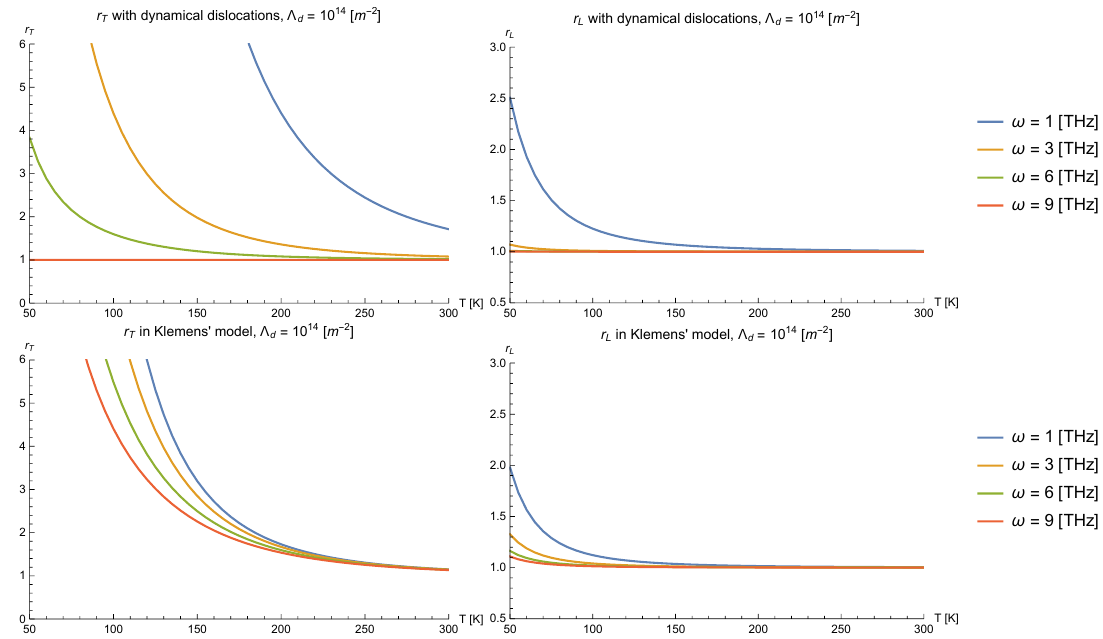
Figure 8. Differential anisotropy ratio r ι as a function of temperature T for different frequencies ω . Upper panels: Present work, based on a dynamical response of dislocations to phonons. Lower panels: Klemens model, based on a static response of dislocations to phonons. Left-hand-side panels: Transverse polarization. Right-hand-side panels: Longitudinal polarization. The plots were calculated for γ = 2, g = 3, G = 2, b = 3.5 × 10 − 10 m, a dislocation density of Λ d = 10 14 m − 2 , and the intrinsic phonon lifetimes parametrizations of Ge [45]. There is a significantly different anisotropy as a function of frequency between the dynamic and static cases, particularly for transverse